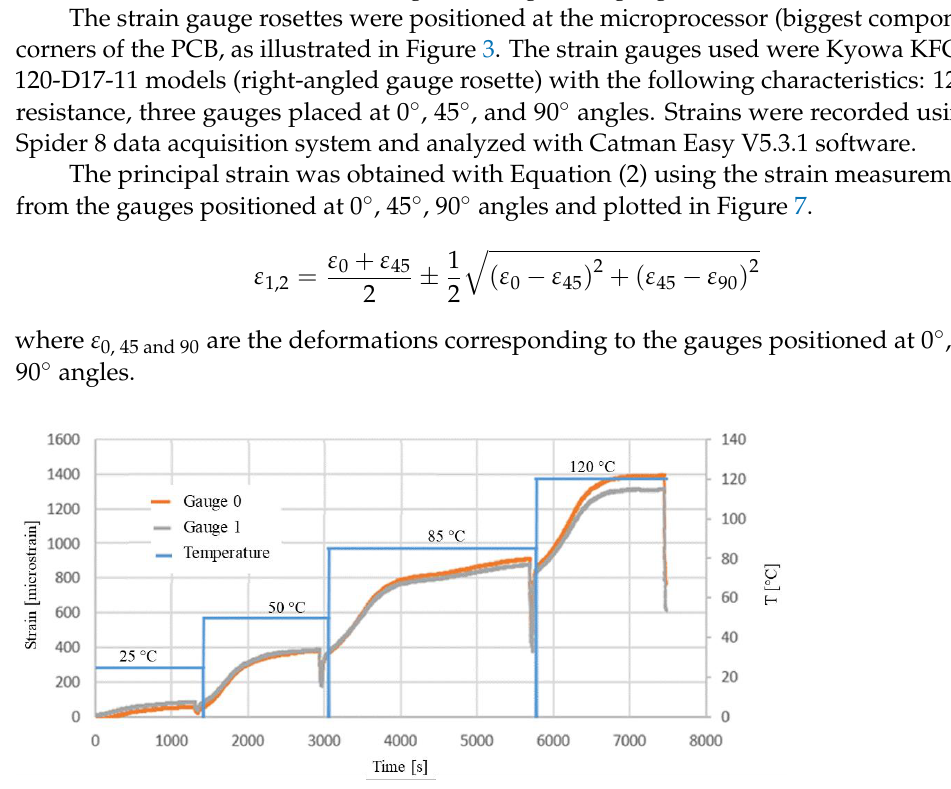
Figure 7. The principal strain-strain gauge measurement.